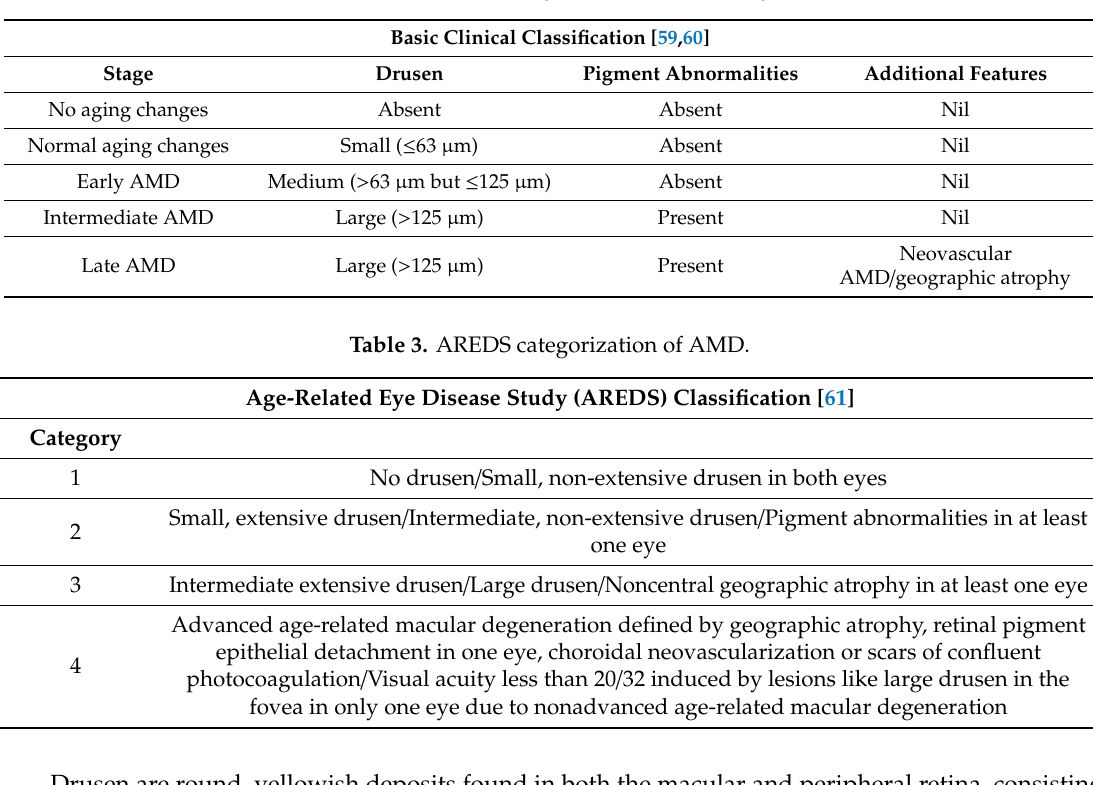
Table 2. Basic clinical classification of age-related macular degeneration (AMD).